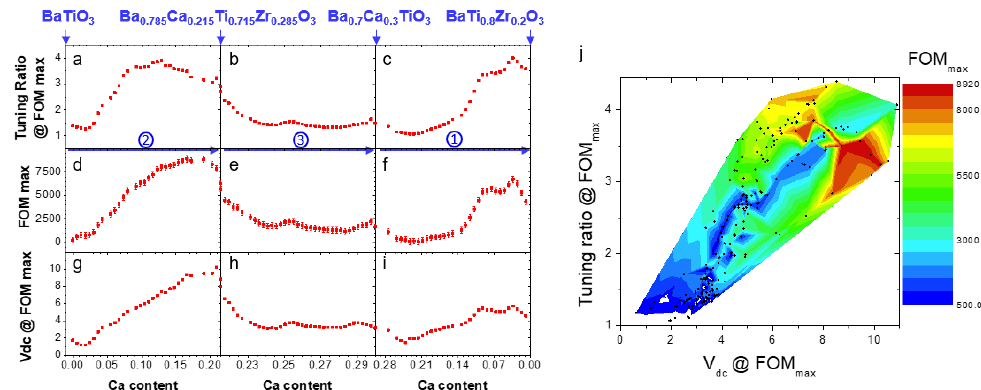
Figure 6. ( a – c ) TR at FOM max , ( d – f ) FOM max and ( g – i ) V dc at FOM max along route 2 (BTO-BCTZ), route 3 (BCTZ-BCT) and route 1 (BCT-BST) (from left to right). ( j ) Map of FOM max vs. TR at FOM max and V dc at FOM max for all the capacitors (binary and ternary systems) characterized at high voltage. Black dots are the actual data points.